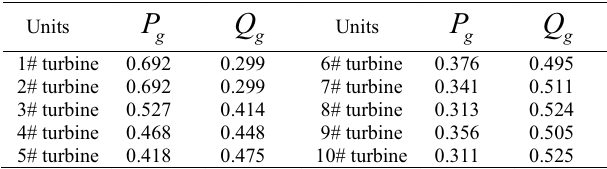
Table 7. Active power and reactive power allocation results